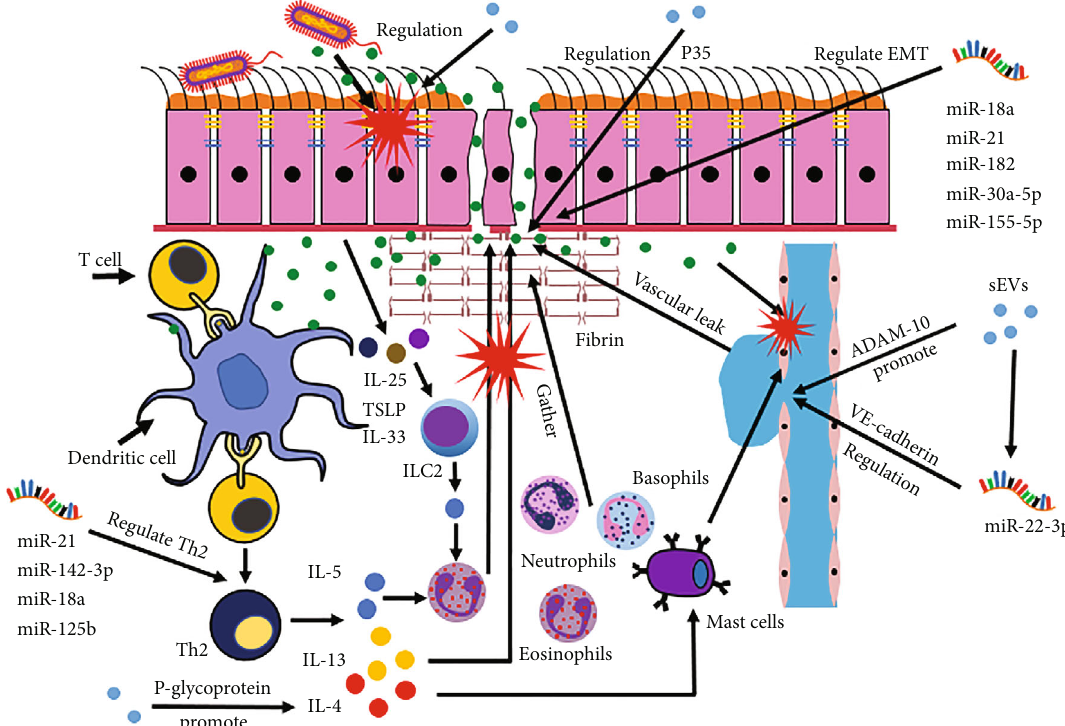
Figure 2: Regulation of exocrine and miRNAs in nasal